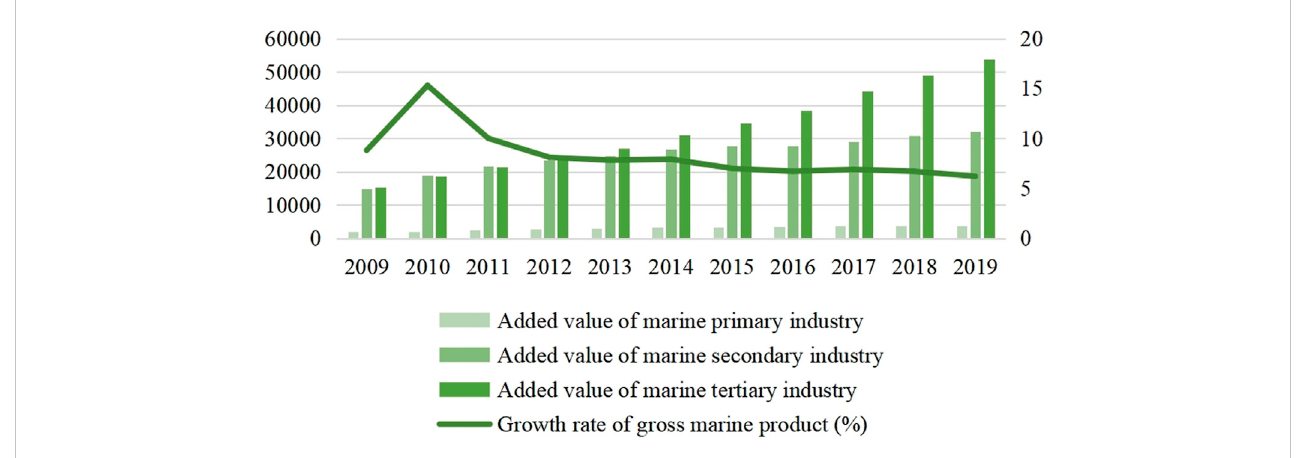
FIGURE 1 Marine economic growth of China from 2009 to